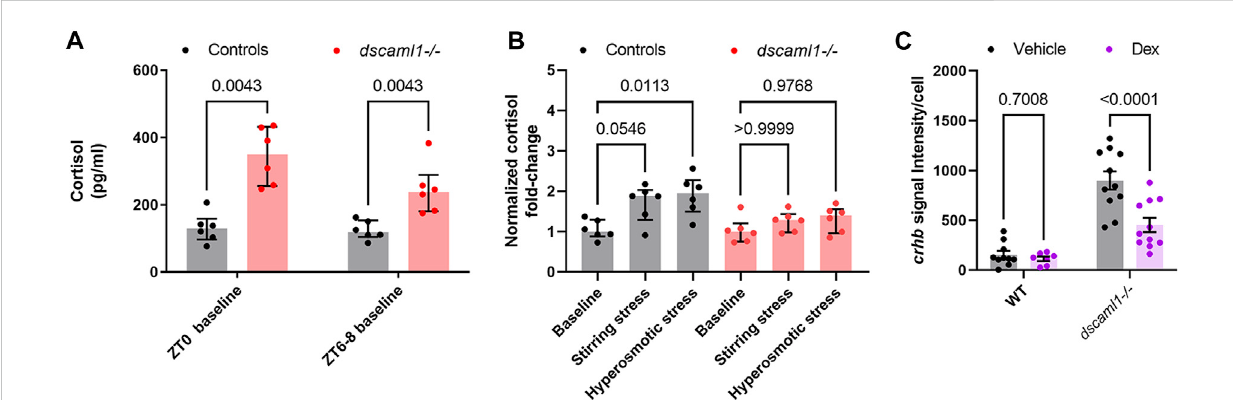
FIGURE 7 Cortisollevels andresponsetoexogenousglucocorticoids. (A – B) Cortisolpro fi lefor5dpflarvae.Foreachsample(dot),cortisolwasextracted from a pool of 30 animals. n = 6 for all groups. Median, interquartile range, and corrected p values are shown. (A) Baseline cortisol in control (black) and dscaml1 − / − (red) animals. (B) Baseline-normalized cortisol fold change in control (black) and dscaml1 − / − (red) animals. (C) Quanti fi cation of crhb signal intensity per cell in CRH NPO neurons. Vehicle: n = 10 (WT), 11 ( dscaml1 − / − ). Dex: n = 7 (WT), 11 ( dscaml1 − / − ). Mean, standard error, and corrected p values are